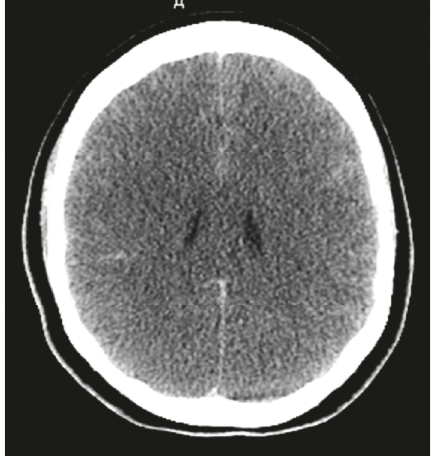
Figure 1: Noncontrast head computed tomography (CT) showing diffuse sulcal effacement and obliterated basal cisterns.